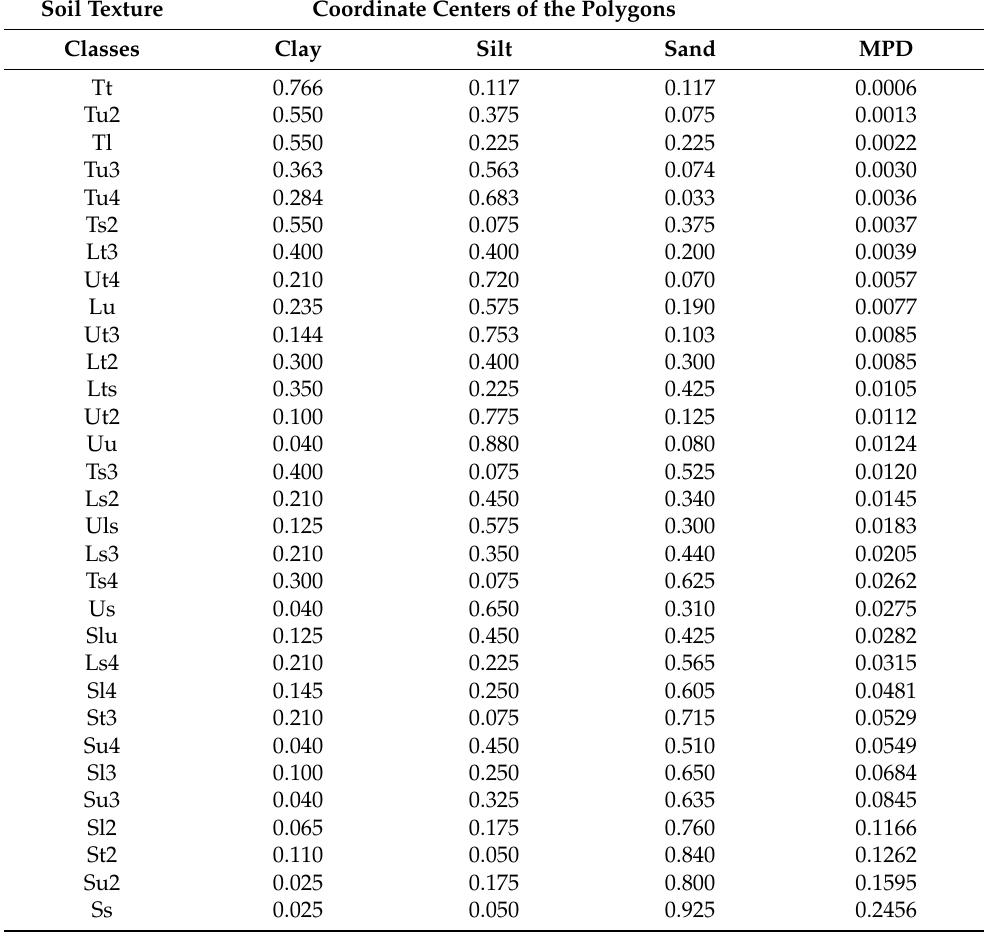
Table 2. Clay, silt, and sand contents [kg kg − 1 ] and the corresponding mean particle diameters (MPDs) [10 − 3 m] of the 31 DBG soil texture